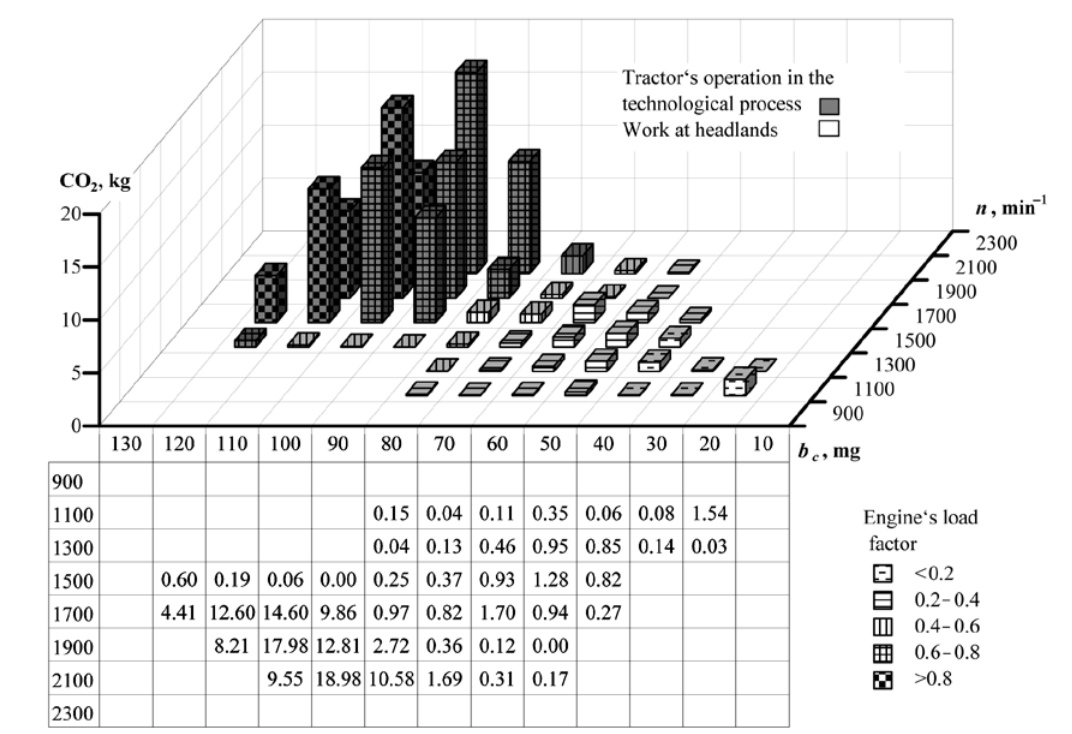
emissions during the test period of drilling (3867 s) in the modes of engine speed ( n ) Fig. 11. Distribution of CO 2 and cyclic fuel injection quantity ( b c